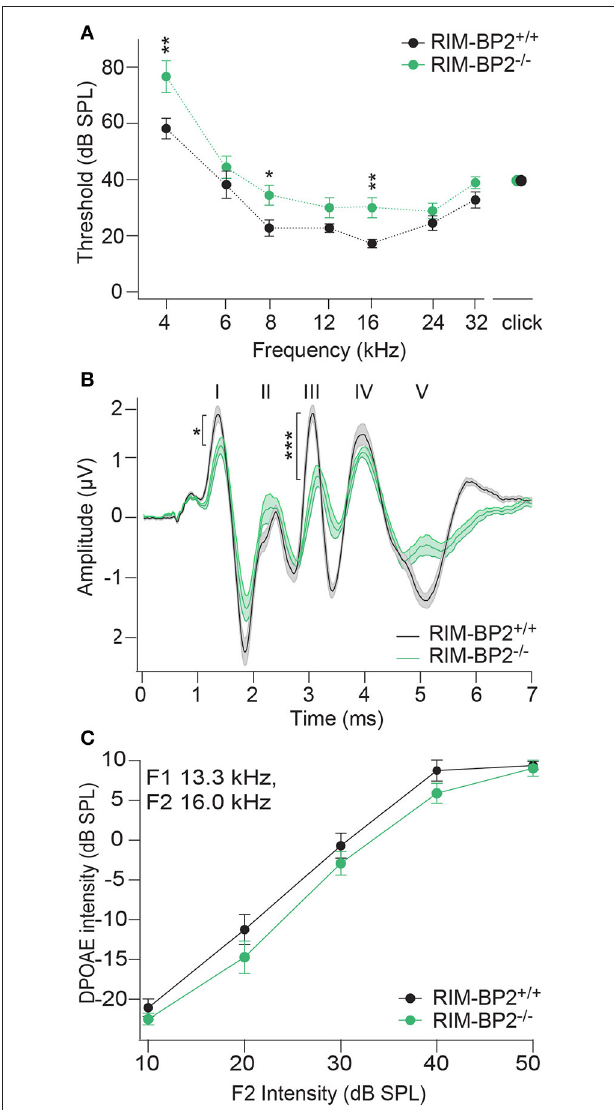
FIGURE 10 | RIM-BP2 disruption caused a mild synaptopathic hearing impairment. (A) Auditory brainstem response (ABR) thresholds were elevated in RIM-BP2-deficient mice compared to control mice especially at 4 ( p = 0.005), 8 ( p = 0.02), and 16kHz ( p = 0.002). (B) Compared to control mice ABR waveforms (80 dB peak equivalent, 20Hz stimulation rate) of RIM-BP2-deficient mice elicited a significantly reduced ABR wave I amplitude ( p = 0.03), representing the compound action potential of SGNs. (C) At the frequency of strongest hearing threshold increase 16kHz, see (A) , otoacoustic emission amplitudes were unaltered in RIM-BP2-deficient mice compared to control mice indicating normal mechanoelectrical transduction and cochlear amplification (F1: 13.3kHz, F2: 16kHz) ( p = 0.1–0.9). (A–C) RIM-BP2 + / + ( n = 11), RIM-BP2 − / − ( n = 8); Data information: Data represent grant averages, mean ± SEM; one way ANOVA, p -values are from post hoc Tukey’s multiple comparison: * p < 0.05, ** p < 0.01, *** p < 0.001; n = number of mice; age of mice: 8–10